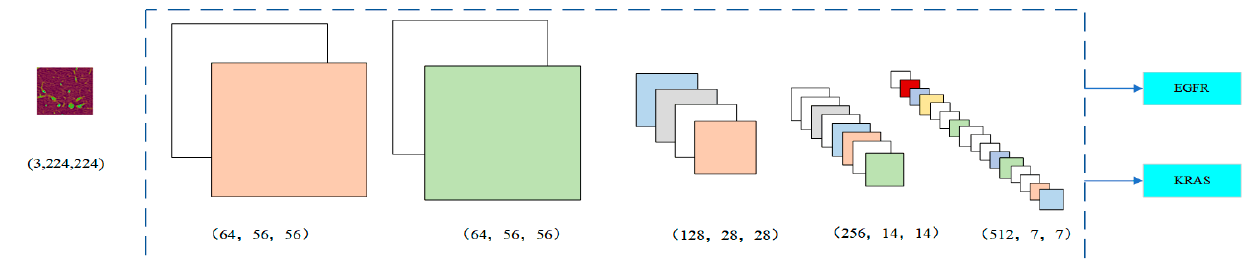
Figure 4. Number of image channels in each stage.